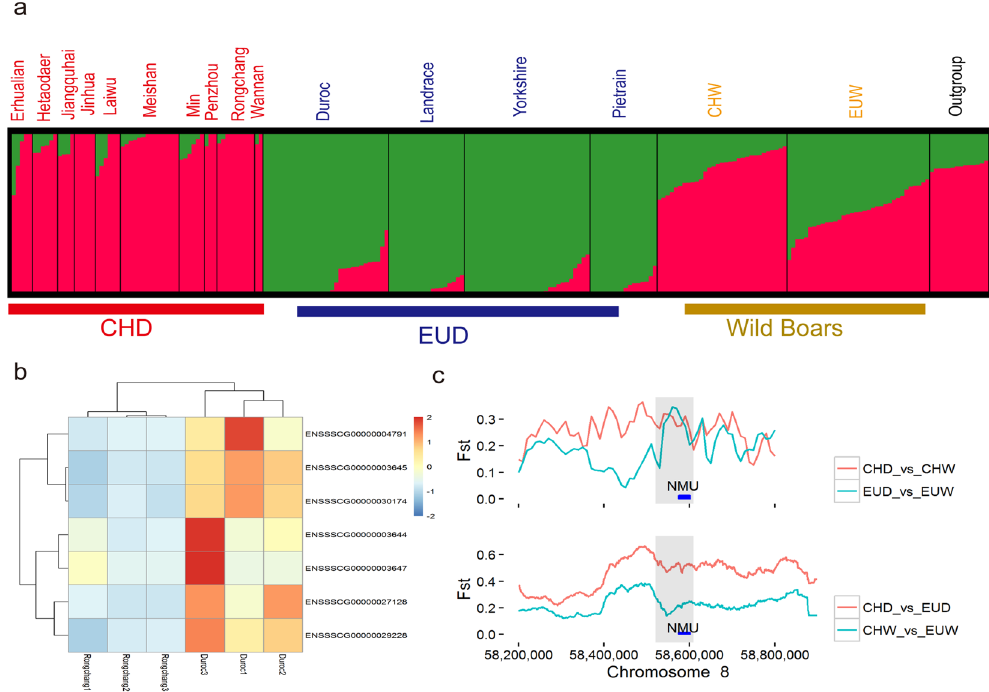
Figure 6. Genomic regions under bidirectional selection and the heatmap for the gene expression of DEG near bidirectional regions in two different breeds. ( a ) Genetic structure of pig breeds in bidirectional selection region. The length of each colored segment represents the proportion of the individual’s genome from K = 2 ancestral populations. The group names are at the top of the figure, and the breed names are at the bottom. ( b ) Heatmap from hierarchical clustering of DEG near bidirectional selection regions. The heatmap was plotted scaled by row. Heat-map colors (right) indicate the relative FPKM. ( c ) Example of a gene under bidirectional selection pigs. FST values plotted using a 20-kb sliding